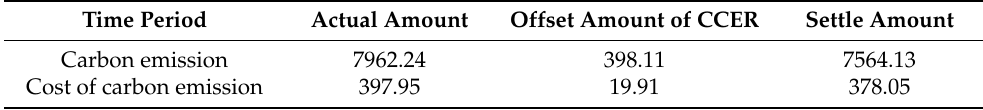
Table 3. Offset of